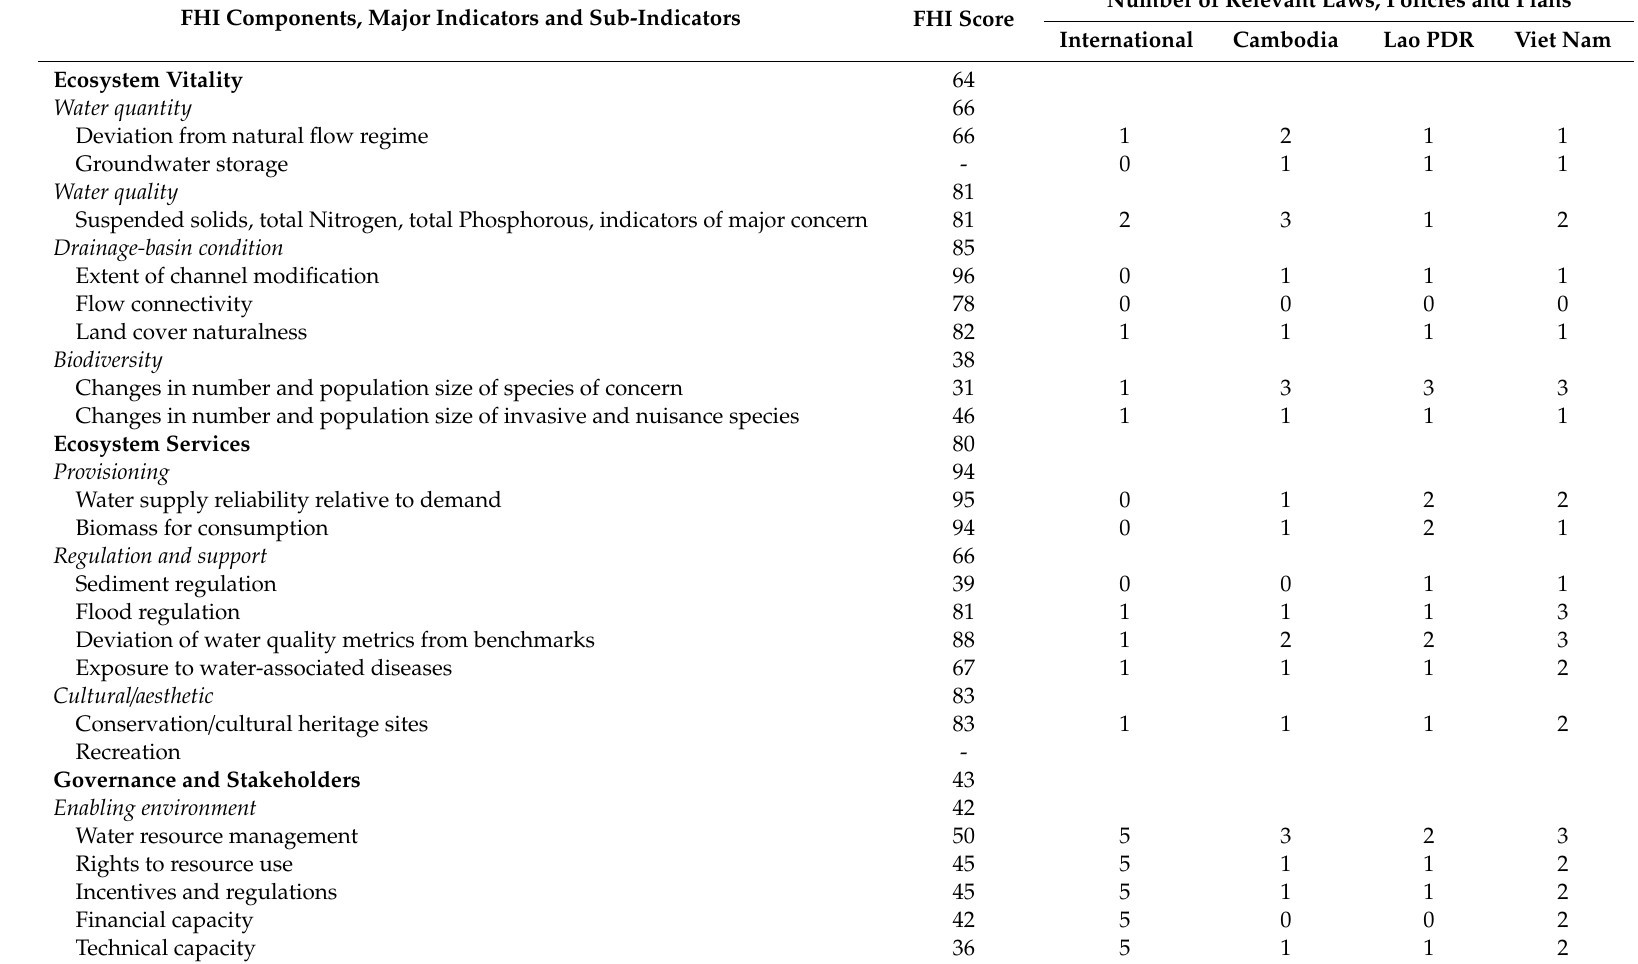
Table 1. Freshwater Health Indicator components, major indicators and sub-indicators, their 3S basin score [13], and the number of laws, policies, and plans they align with, in each of the three